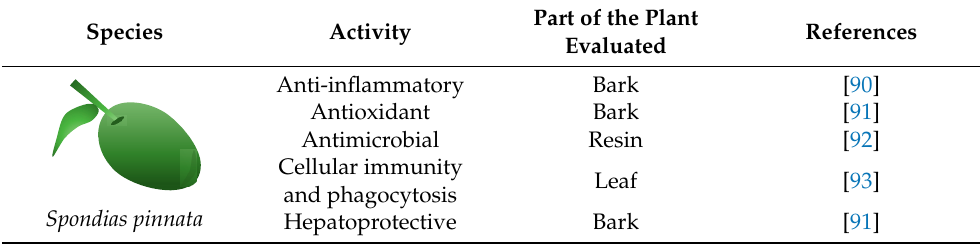
Table 5. Summary of Spondias pinnata activity in different parts of the plant, as described in the last few years.